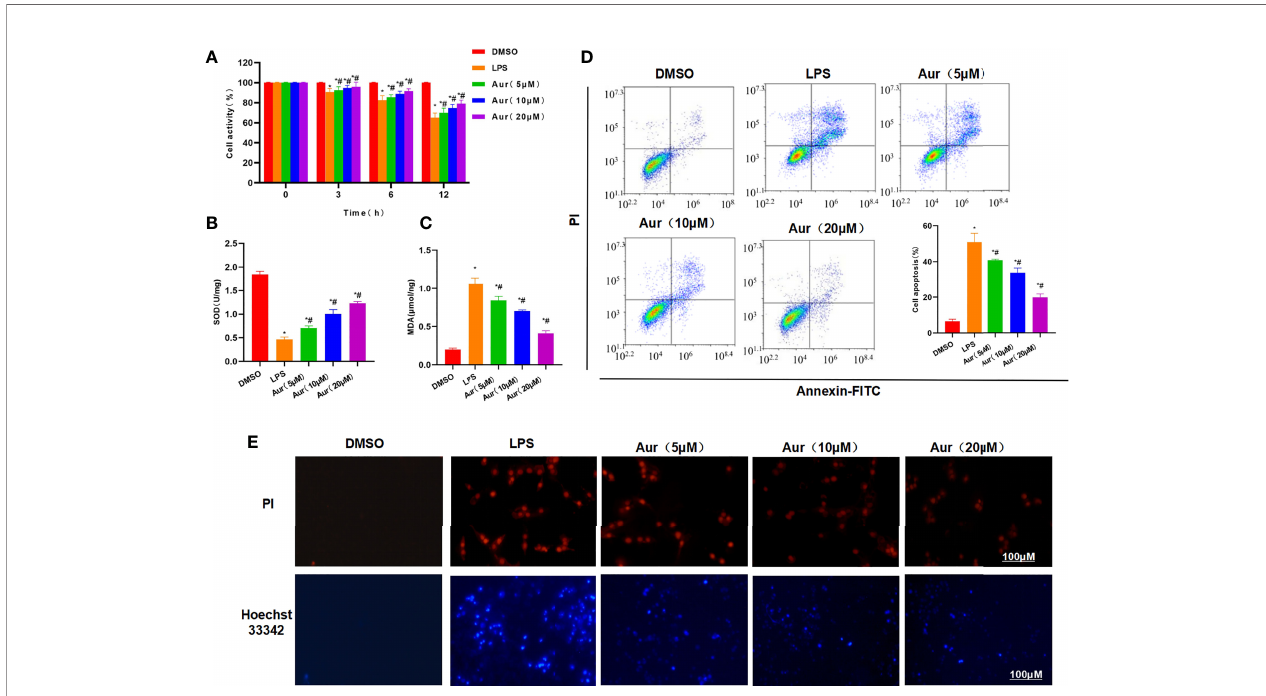
FIGURE 1 | Effect of Aur on LPS-induced KC injury. (A) : Effect of Aur on cell viability (n = 3): The cell viability in the LPS group was signi fi cantly more decreased than the DMSO group; while Aur treatment could suppress the decrease in viability, which was signi fi cantly different from the LPS group. In addition, the pairwise comparison was also statistically signi fi cant. Comparison with DMSO, *P <0.05; comparison with LPS group, # P <0.05. (B, C) : Effect of Aur on SOD and MDA (n = 3): The SOD level was downregulated and the MDA level was upregulated in the LPS group, which were signi fi cantly different from the DMSO group. Aur treatment could decrease the MDA level and increase the SOD level in a dose-dependent pattern. Comparison with DMSO, *P <0.05; comparison with LPS group, # P <0.05. (D) : Apoptosis assay (n = 3): The apoptotic level was low in the DMSO group, LPS could signi fi cantly increase the apoptotic level, and Aur could downregulate the apoptotic level. Comparison with DMSO, *P <0.05; comparison with LPS group, # P <0.05. (E) : PI staining and Hoechst 33342 staining (n = 3): Positive cells were barely detectable in the DMSO group, which were signi fi cantly upregulated in the LPS group. While the number of positive cells was downregulated in the Aur group, indicating the suppressed